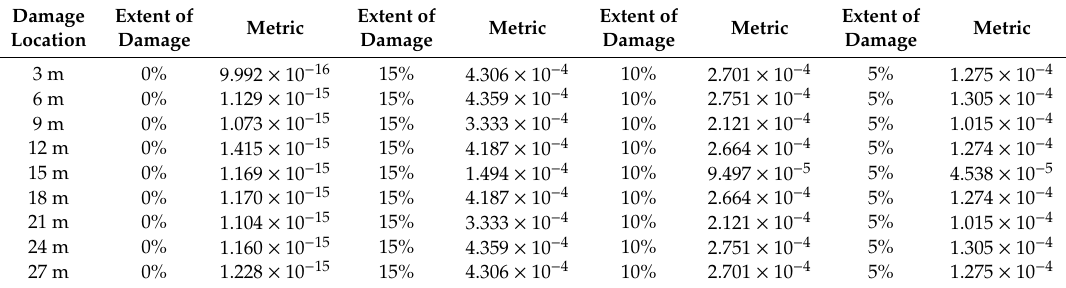
Table 2. Comparison of the metrics of the damage features of the different cases.